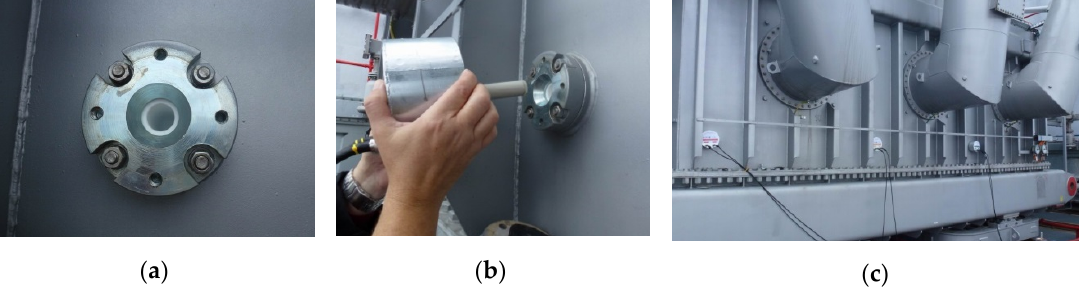
Figure 3. The antenna inlet on the side wall of the transformer ( a ); sensor installation ( b ); the installed sensors ( c ).